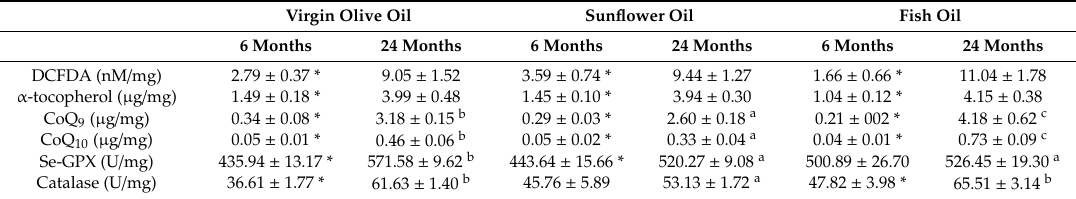
Table 5. Oxidative stress and antioxidants markers of rats fed for 24 months on virgin olive oil or sunflower oil or fish